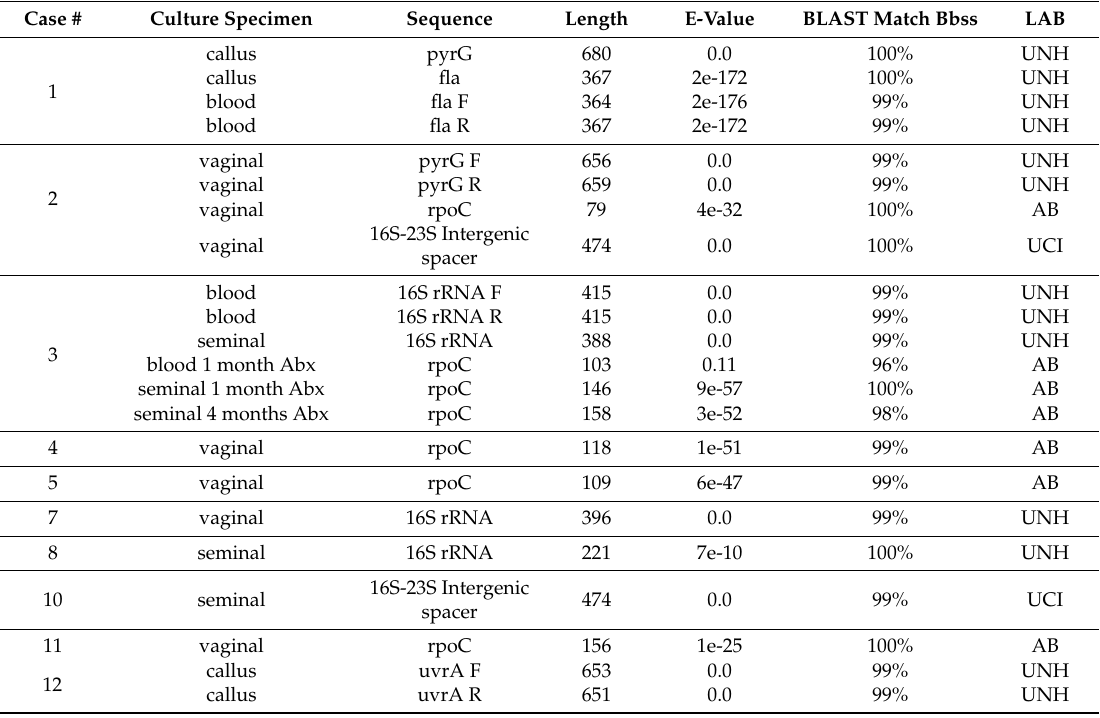
Table 5. Summary of BLAST Sequence Analysis of Patient PCR